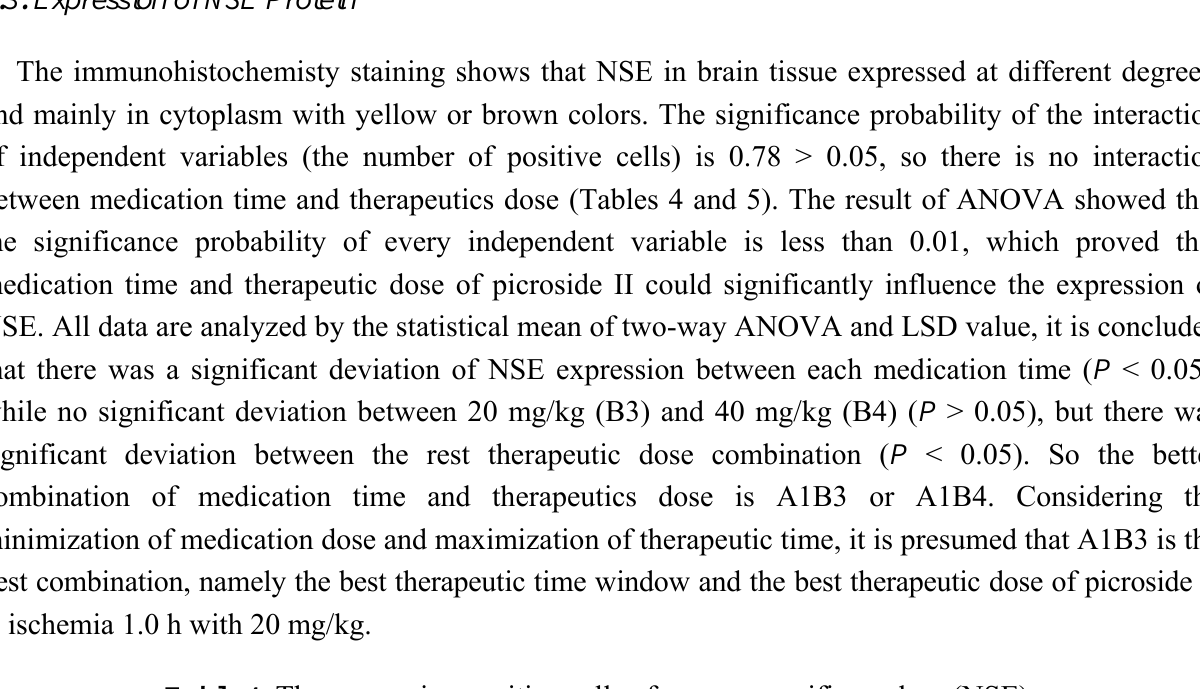
Table 4. The expression positive cells of neuron specific enolase (NSE).